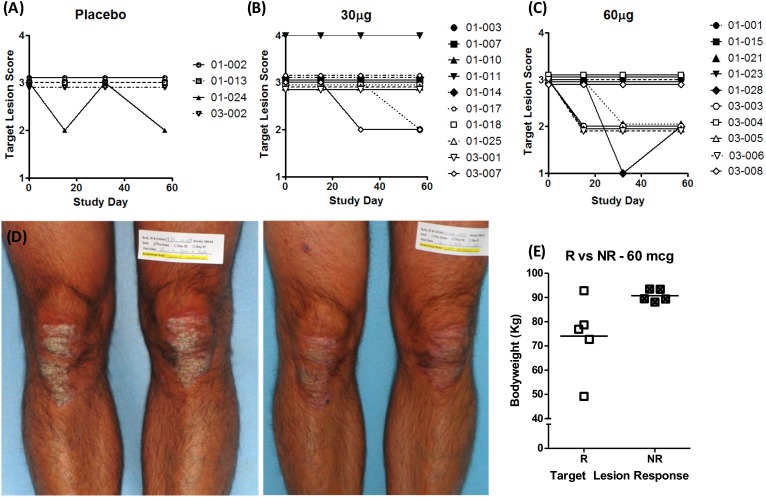
Individual TLIGA scores over time.Placebo group (A), 30 mcg/dose group (B), and 60 mcg/dose group (C). Dalazatide clinical activity shown as improvement in target lesion for a patient after 4 weeks of treatment from the 60 mcg/dose group (D). Individual TLIGA responses by baseline body weight in the 60 mcg/dose group at Day 32 (E). R = improvement in target lesion; NR = no improvement. Bars indicate mean body weight for each subgroup.